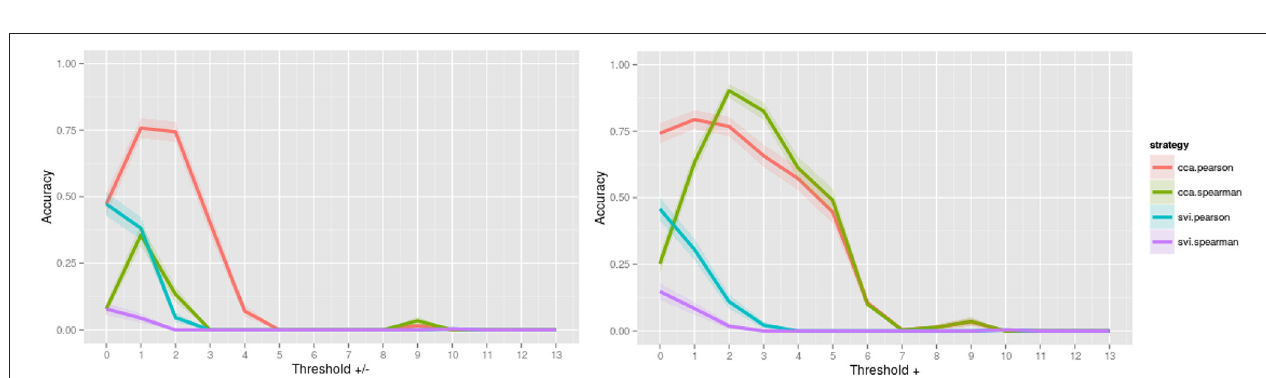
FIGURE 2 | Accuracy of image contrast classification at varying levels of image thresholding, for comparison of an unthresholded image against a set of images at each threshold, including positive and negative values (left) and positive values only (right). Complete case analysis (CCA) with a Pearson score had a maximum accuracy of 0.984 for a threshold of Z = ± 1.0 (0.983, 0.985), outperforming single-value imputation (SVI).